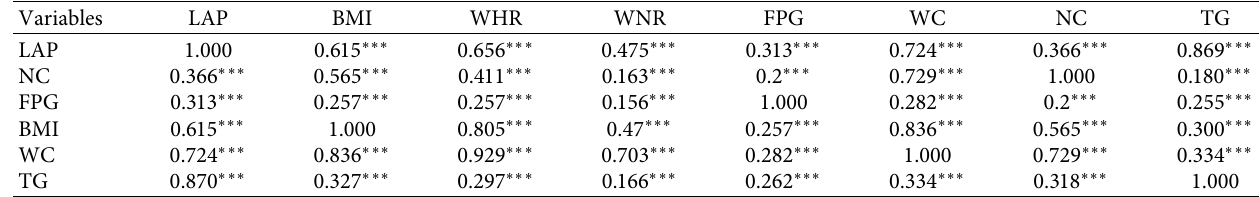
Table 4: Spearman correlation analysis between LAP and related factors.